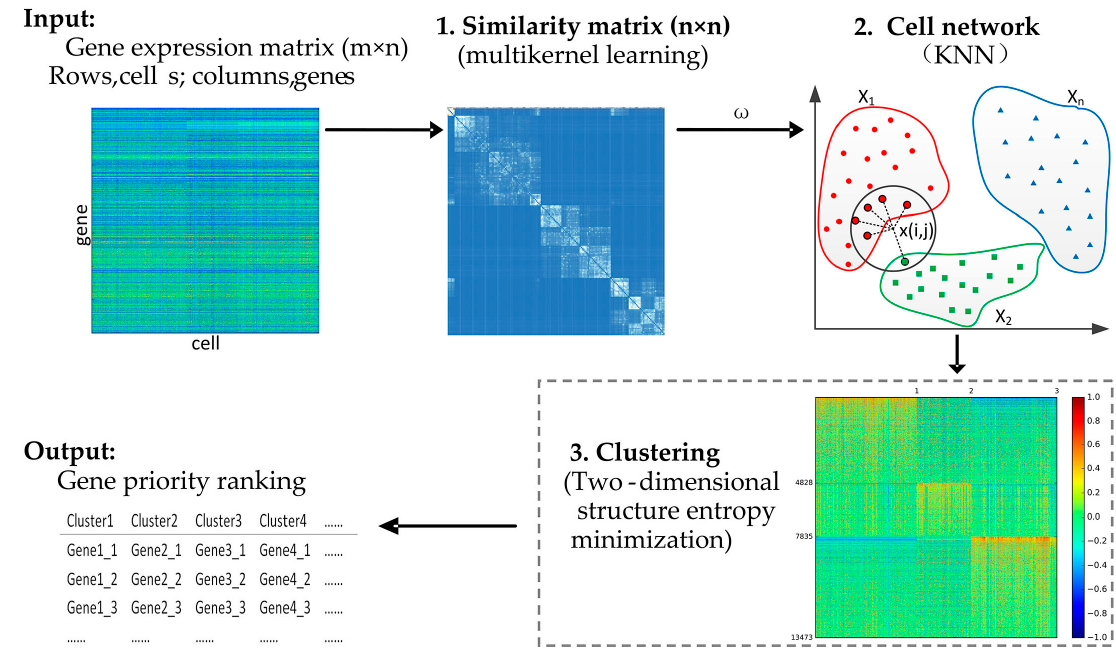
Figure 1. The mechanism of the SSE (single-cell structure entropy minimization principle) algorithm. The input is a gene expression matrix. The SSE algorithm includes three steps: ( 1 ) The similarity is calculated by multikernel learning; ( 2 ) the cell network is constructed by KNN ( k nearest neighbor); ( 3 ) clustering is implemented using the structure entropy minimized principle. Lastly, gene priority ranking results as an output.